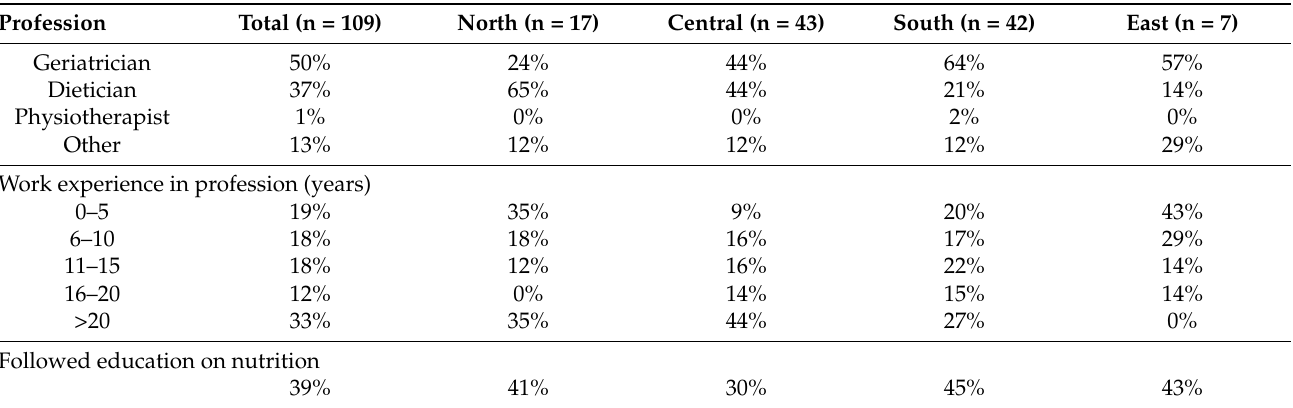
Table 1. Background characteristics of the